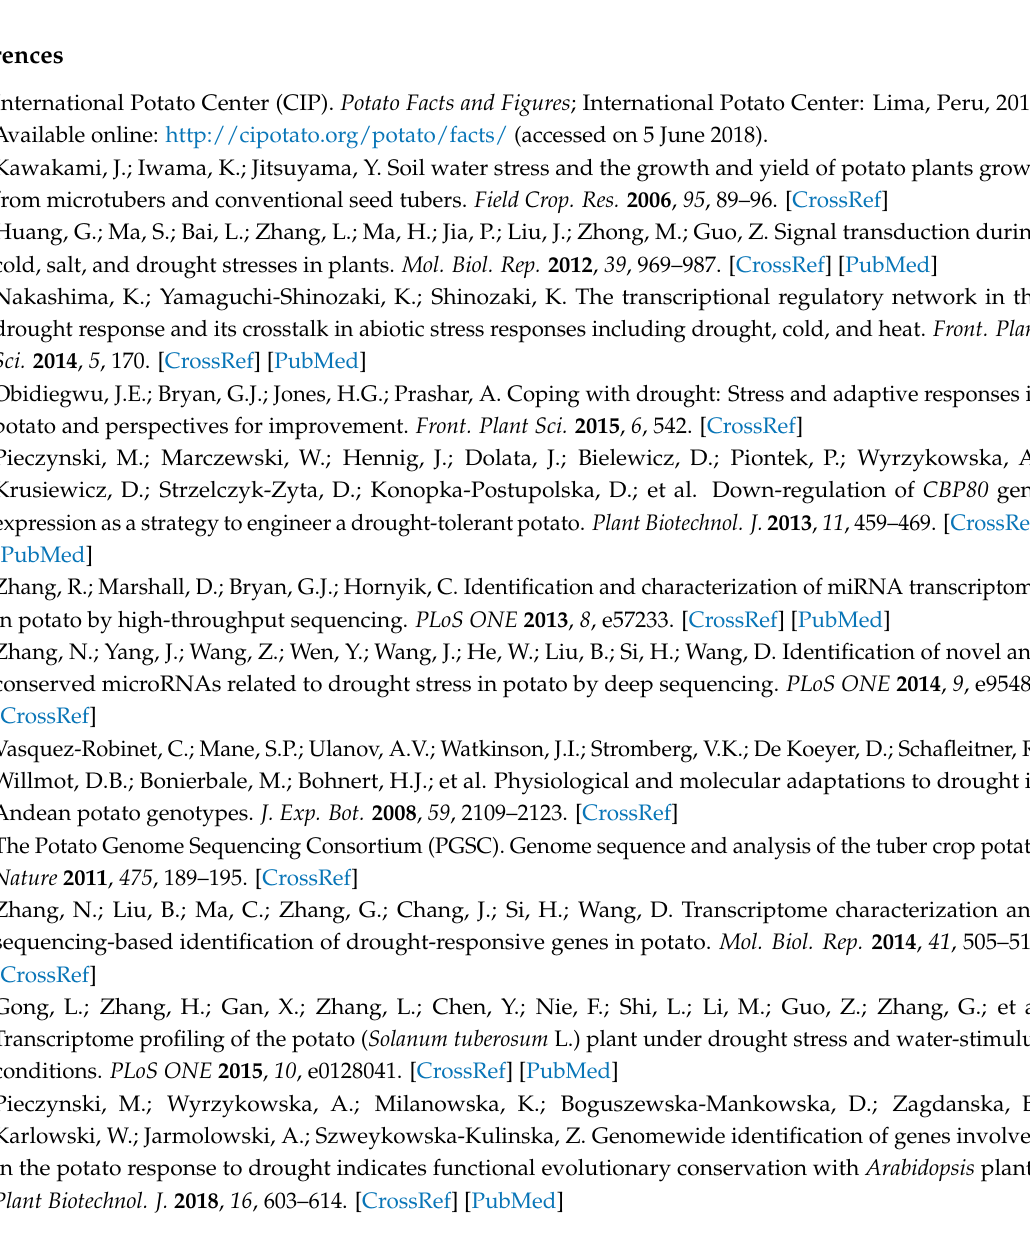
Supplementary Materials: Supplementary materials can be found at http://www.mdpi.com/1422-0067/20/4/